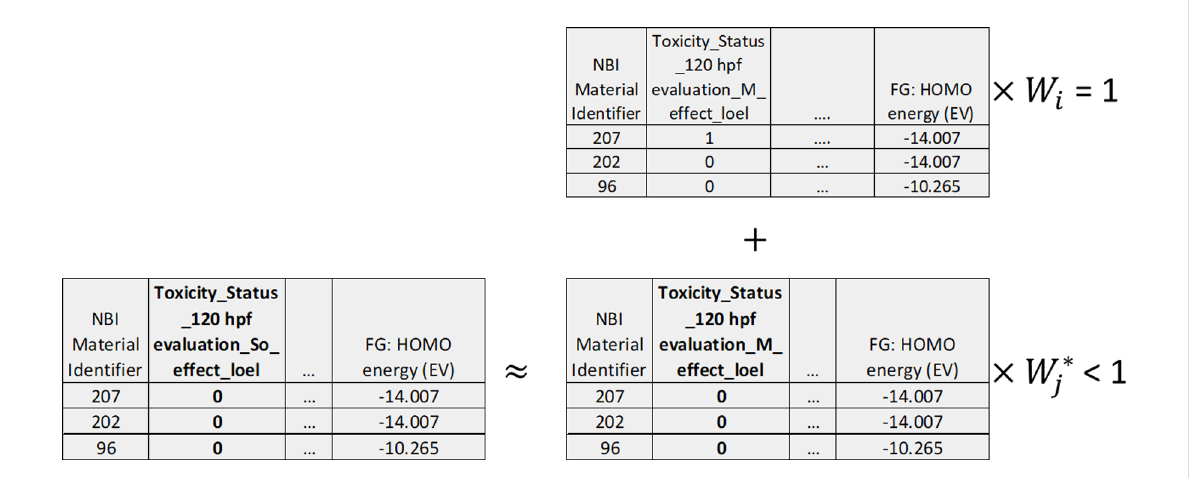
Figure 6: Data augmentation using the “weighted alternative samples” paradigm, where the alternative samples were the original ENM samples from the training set with the binary response values toxic (= 1) vs non-toxic (= 0), corresponding to lethality at 24 hpf or excess lethality at 120 hpf, replaced with the binary response values active (= 1) vs inactive (= 0), corresponding to one of the measured sub-lethal endpoints. Top: a subset of the available training set ENM samples and the corresponding descriptors is shown. The weighting of these true samples during training ( W i ) was set to 1.0. Bottom: the addition of some of the alternative ENM samples is shown. The weighting of these samples during training ( ) was set to the estimated correlation between the modelled lethal endpoint and the sub-lethal endpoint for which the data were treated as additional data for the lethal